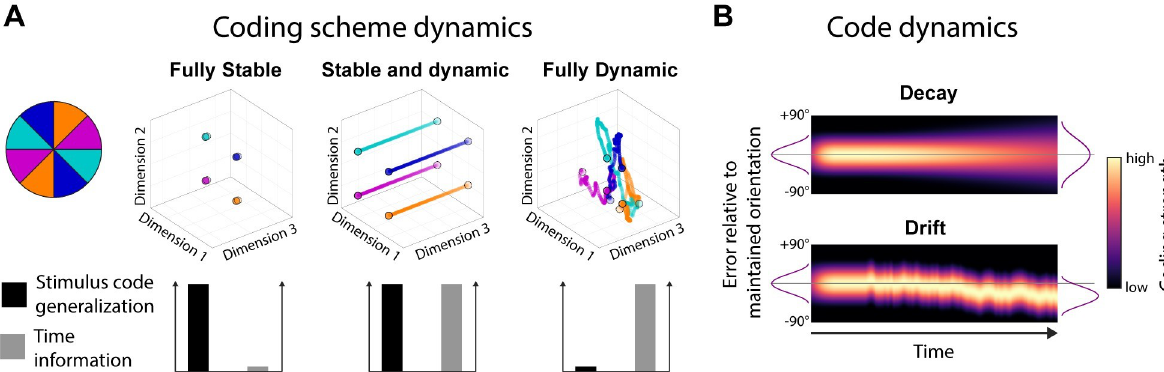
Fig 1. Model predictions. (A) The relationship between the neural coding scheme of orientations (colours) in WM over time, illustrated in neural state space (reduced to three dimensions, for visualisation). Left: A stable coding scheme within a stable neural population (defined by dimensions 1 and 2; dimension 3 has no meaningful variance). Middle: A stable coding scheme (dimensions 1 and 2) within a dynamic neural population (dimension 3). Right: A dynamically changing coding scheme (coding for orientation and time is mixed across dimensions). (B) The fidelity of the population code in WM over time. Top: The code decays and becomes less specific over time, leading to random errors during readout. Bottom: The code drifts along the feature dimension, leading to a still sharp, but shifted code during readout. WM, working memory.